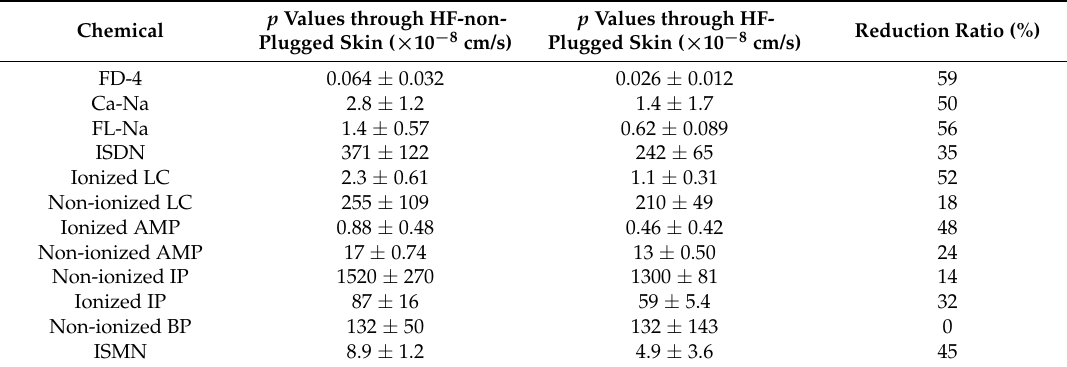
Table 4. Reduction in permeability coefficient of chemicals through the HF-plugged skin. Values are the mean ± S.E. ( n = 3–4).